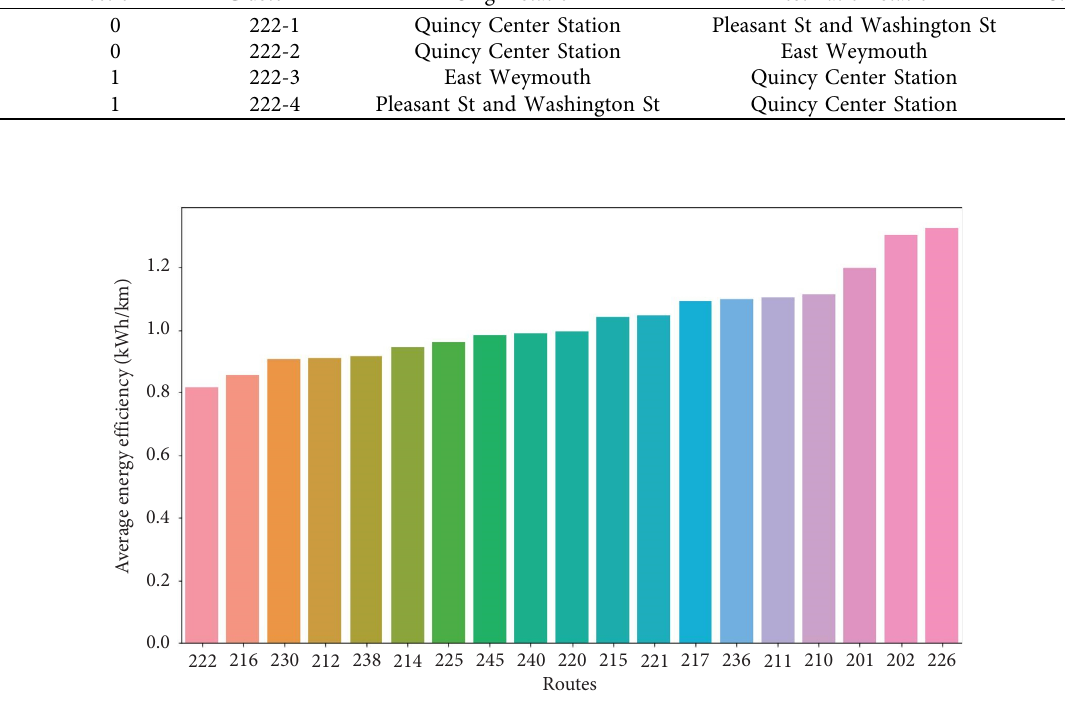
Figure 8: Energy efciency of 40-foot-long electric buses for